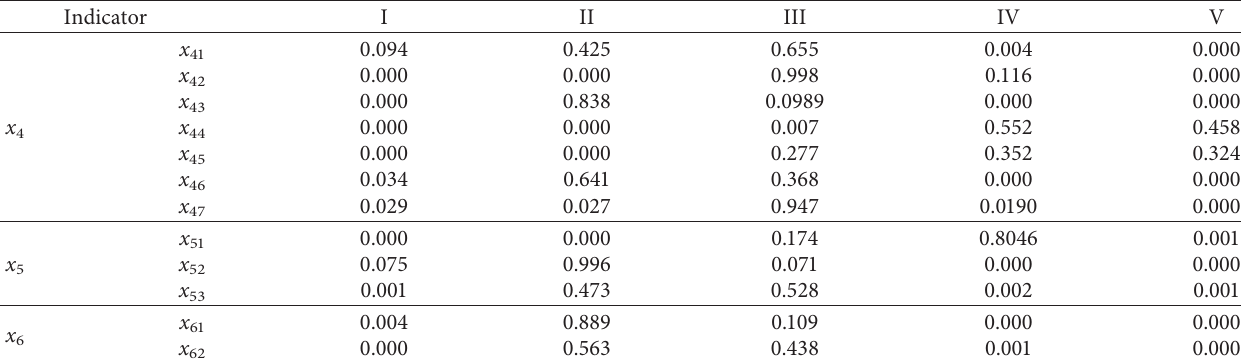
Table 7: Membership degree of environmental vulnerability